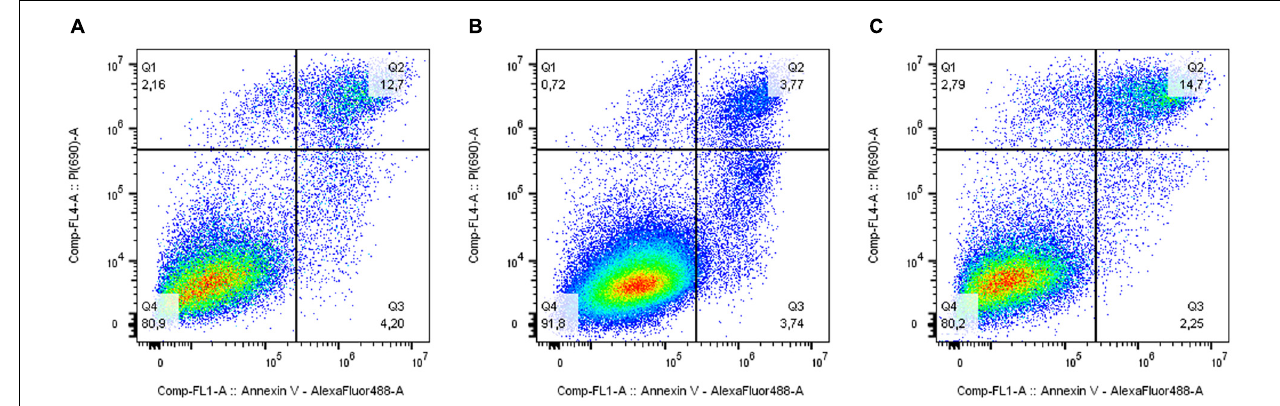
FIGURE 4 | Effect of ELOVL5 and IGFBP6 knockdown on the activation of apoptosis. Two-dimensional plots of the integral fluorescence intensity of the annexin V conjugate with Alexa Fluor 488 dye (horizontal axis) and the integral fluorescence intensity of propidium iodide (vertical axis) in MDA-MB-231 cells with (A) ELOVL5 and (B) IGFBP6 genes knockdown, as well as in (C) controls cells.